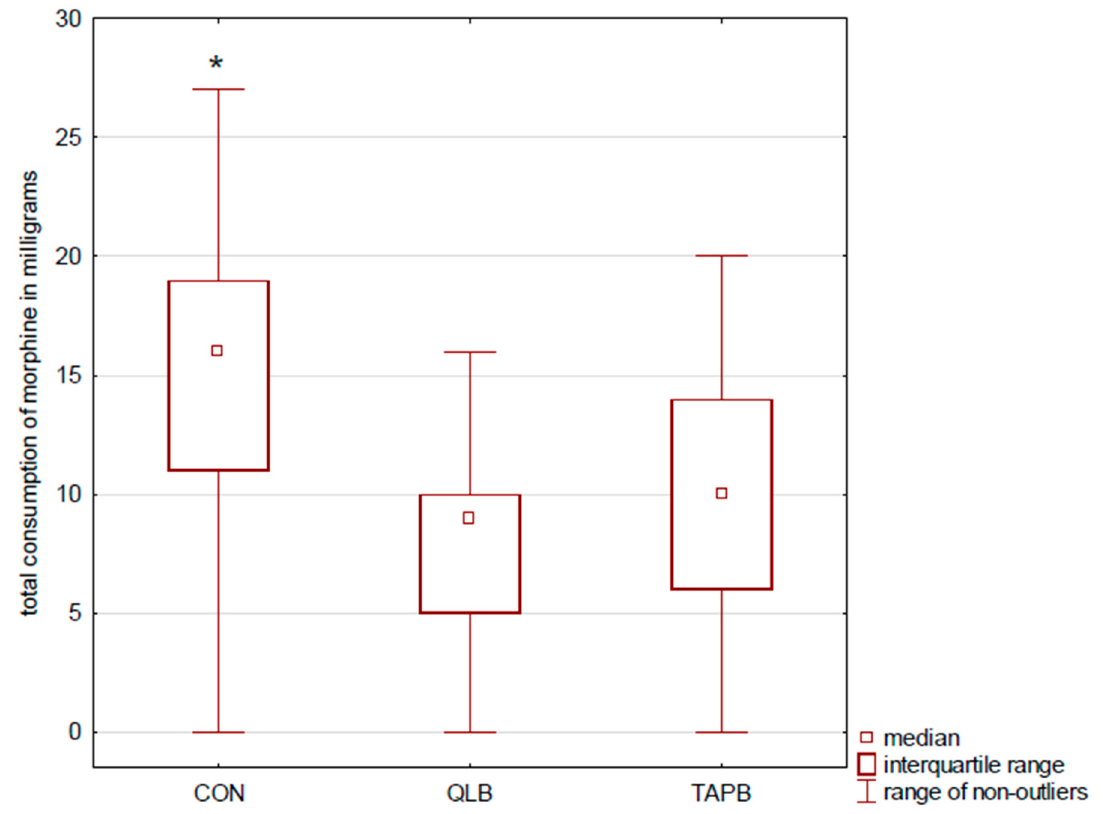
Figure 3. Morphine consumption. The figure presents morphine consumption via PCA pumps during the first postoperative occurrence of pain. Results are presented as medians and interquartile ranges. * indicates statistical significance, CON > QLB, and TAPB. CON denotes the control group, PCA denotes patient-controlled analgesia, QLB denotes the quadratus lumborum block group, and TAPB denotes the transversus abdominis plane block group.